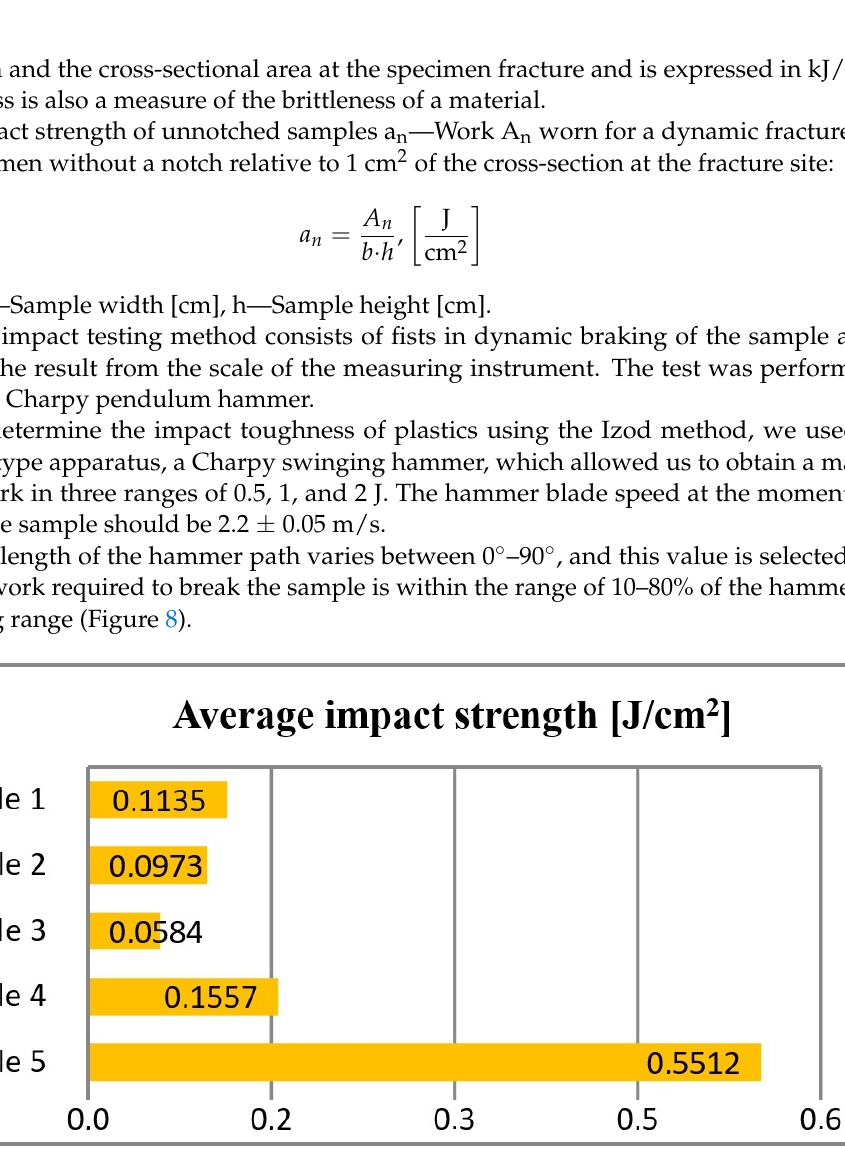
Figure 8. As a result of the impact tests, it was found that sample no. 5 had the highest fracture resistance of 0.5512 [J/cm 2 ]. Sample no. 3 was characterized as the lowest impact strength, equal to 0.0584 [J/cm 2 ].